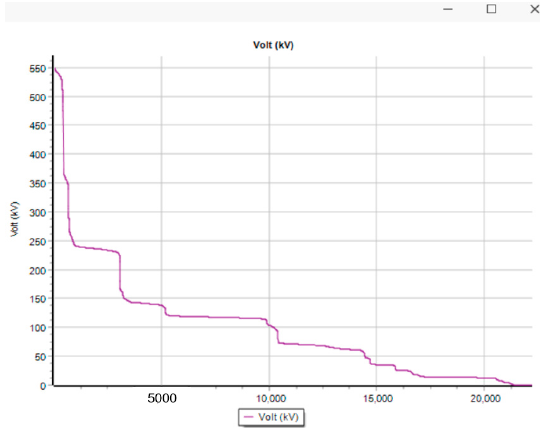
Figure 5. Voltage levels of the full WECC system model.